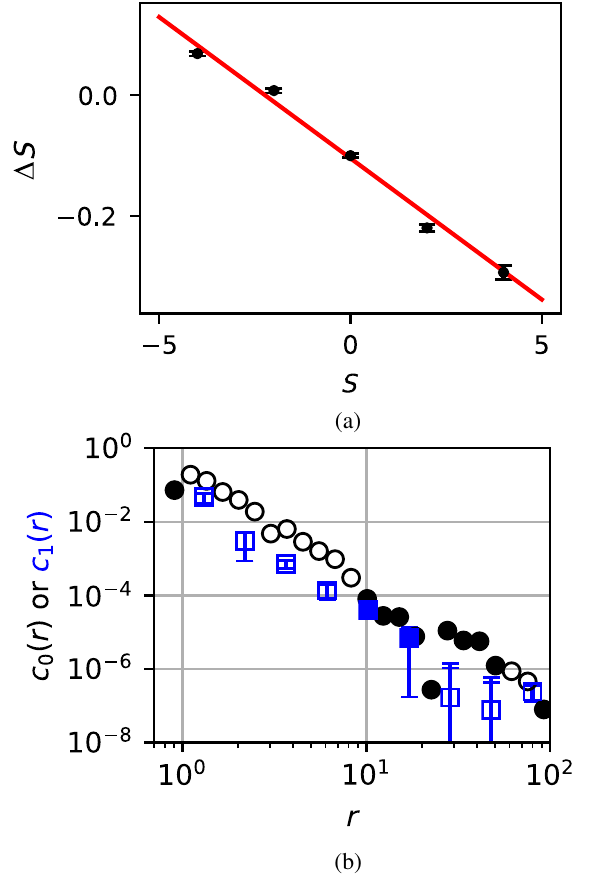
FIG. 7. (a) Mean softness change Δ S per frame for a particle with a given S within a distance of r < 1 . 6 of a rearranger. The red line is the linear fit. (b) The slope of such linear fits c 1 (squares), as well as c 0 (circles) defined in Eq. (5), at different distances r . Solid symbols represent positive values, while open symbols represent negative values. yields the red curve in Fig. 6(a). Note that the red curve provides an excellent description of the black points [ Δ S ð r Þ ], capturing the sign as well as the magnitude in the far field.